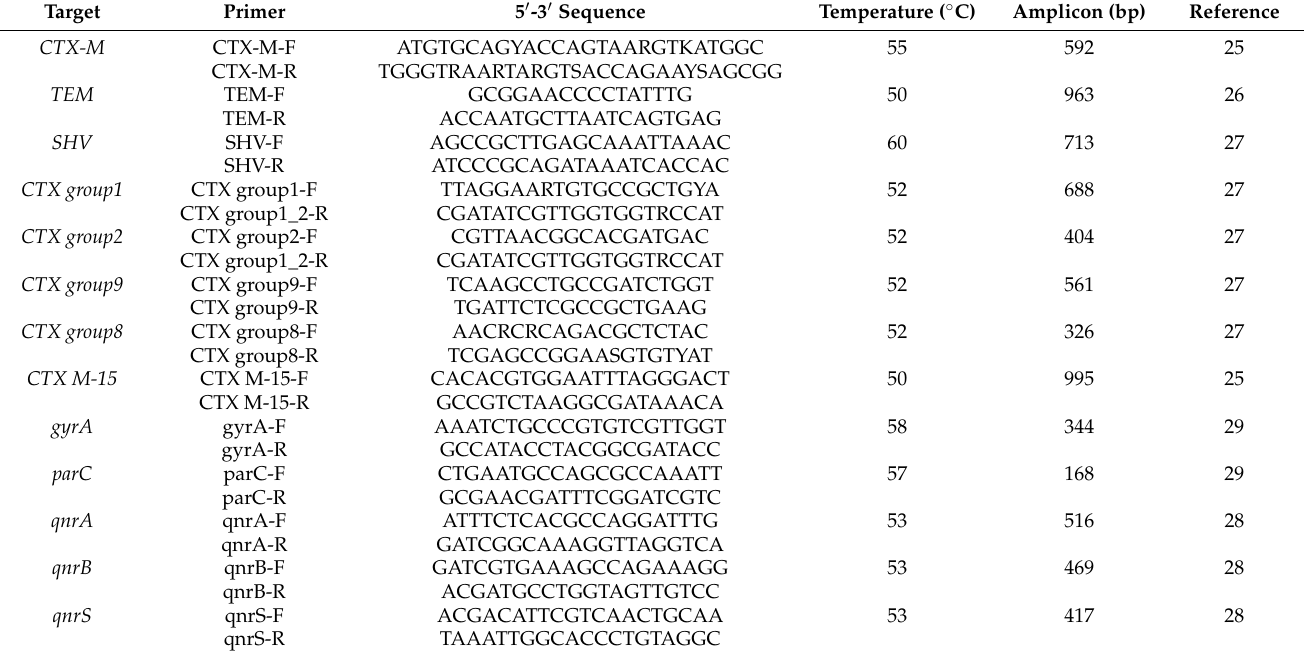
Table 1. Primers used in the